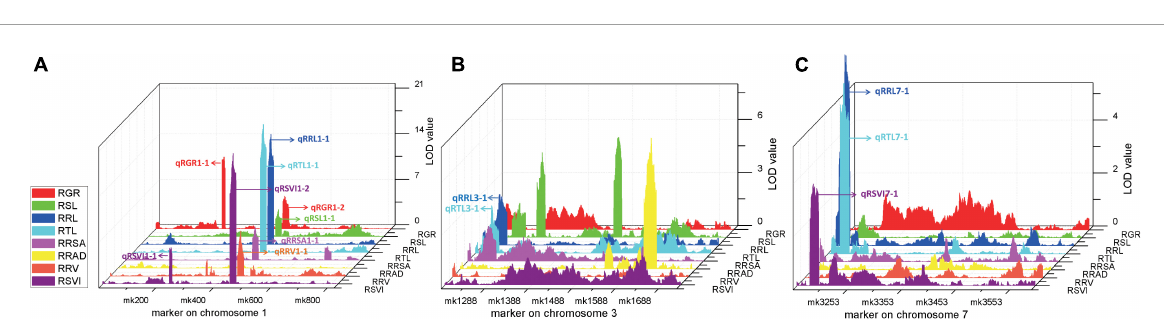
chromosome 5, the least (three) were detected on chromosome 6, four were detected on chromosome 7, four were detected on chromosome 8, 12 were detected on chromosome 9, and five were detected on chromosome 10. These QTLs explained